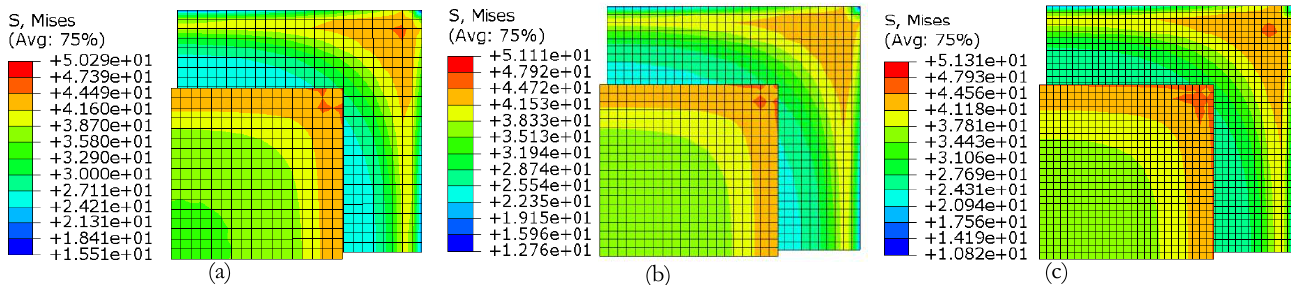
Figure 4: Convergence of stresses in the solder layers: (a) stress contours of coarse mesh, (b) stress contours of medium density mesh, (c) stress contours of fine mesh.